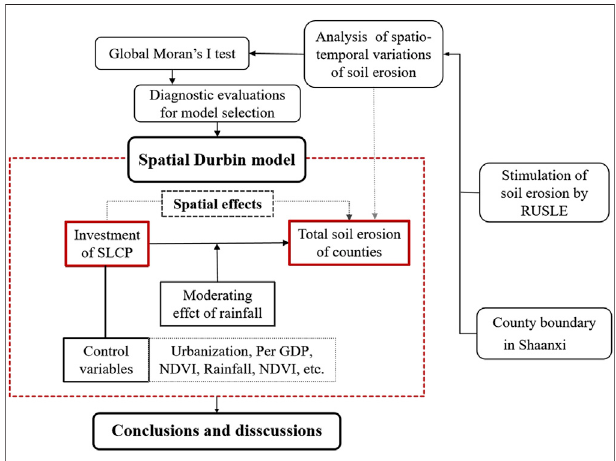
FIGURE 2 | Flowchart of the analysis procedure of this